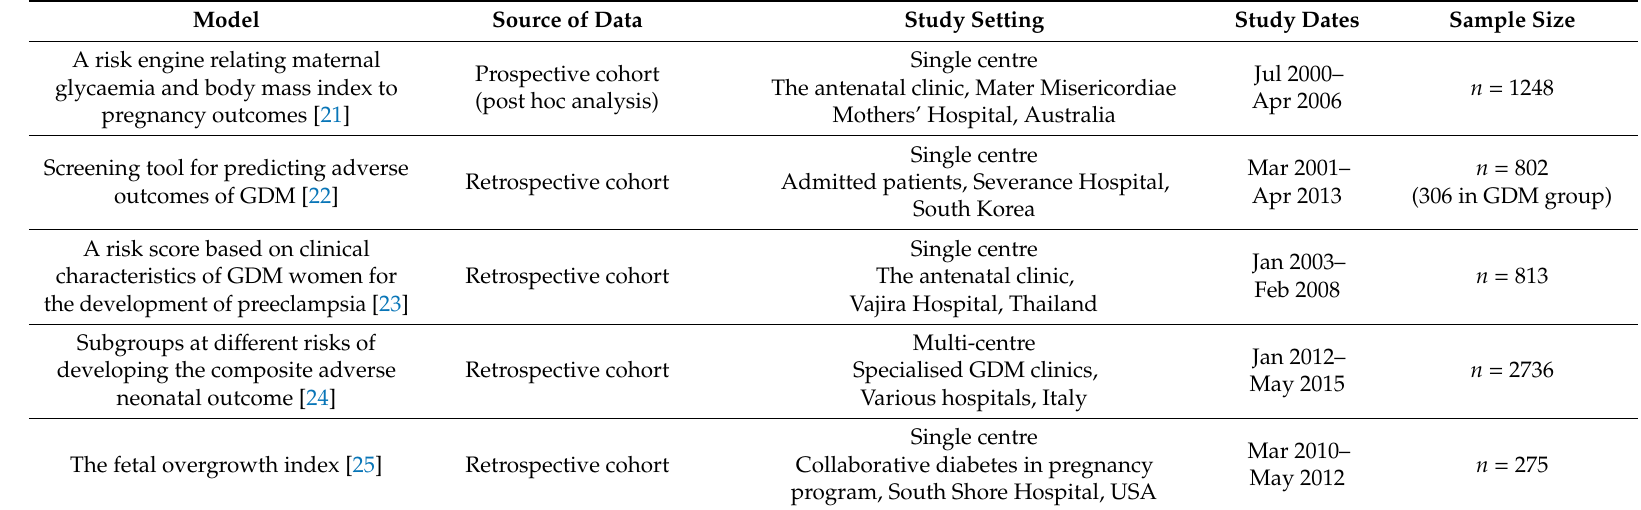
Table 2. Source of data and characteristics of studies used to develop models for pregnancy complications in women with gestational